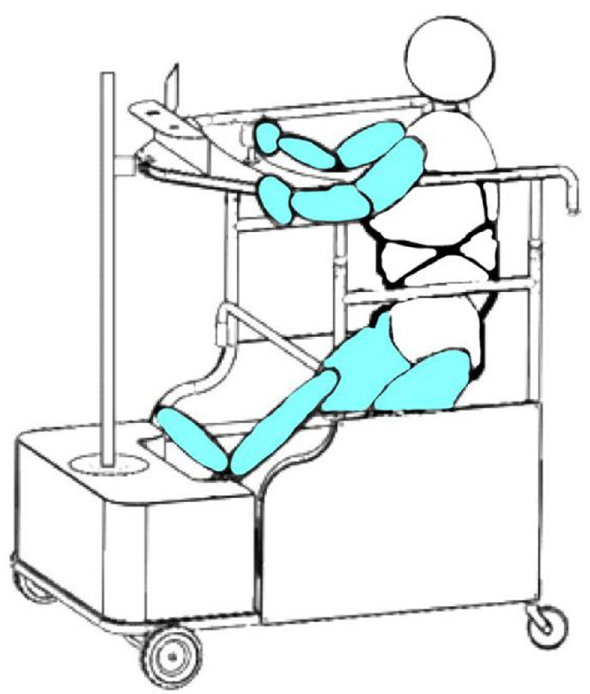
Figure 3: Fall protection